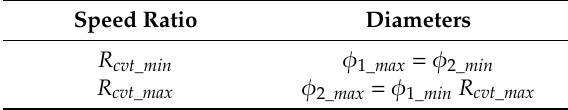
Table 1. Continuously variable transmission (CVT) pulley diameters.